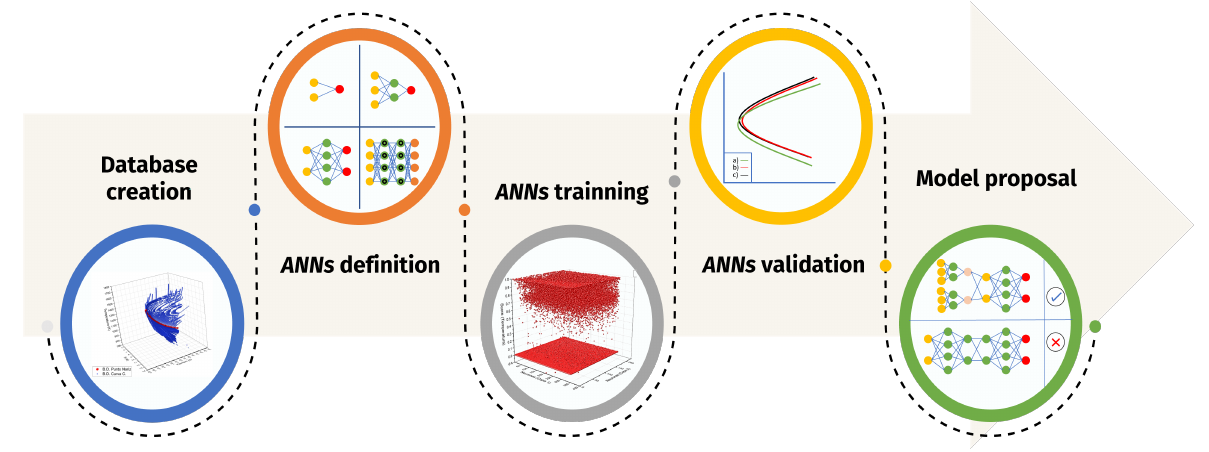
Figure 1. Proposed methodology for determining TTT diagrams using